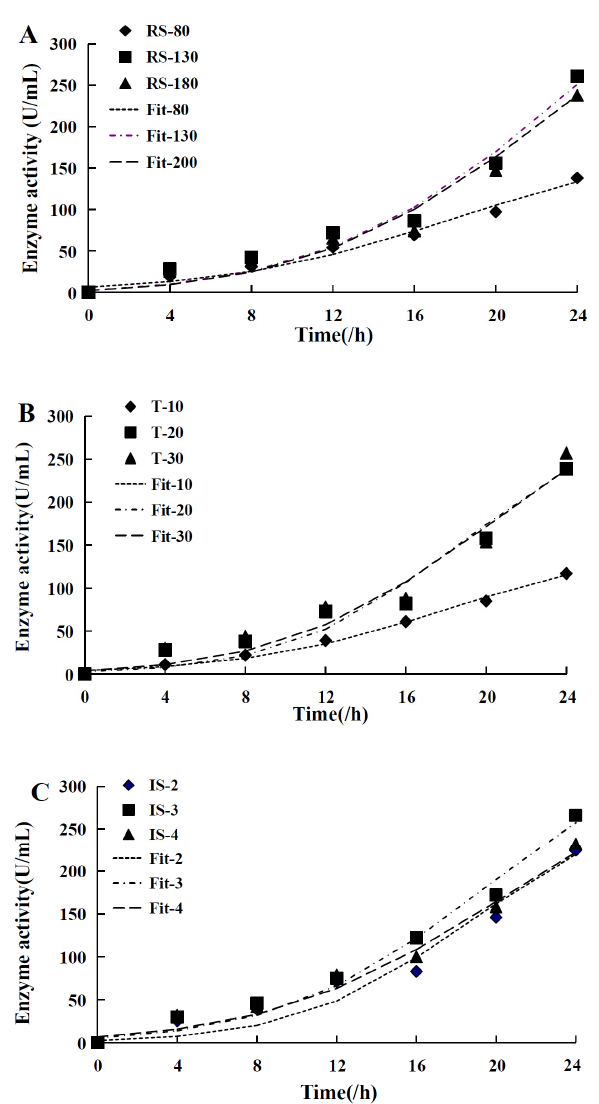
Figure 8. ( A ) was the model fitting of revolving speed relative to enzyme activity, altering variables 80 r/min, 130 r/min and 180 r/min, quantifying temperature 30 °C, and inoculum size 3 mL; ( B ) was the model fitting of temperature relative to enzyme activity, altering variables 10 °C , 20 °C and 30 °C , quantifying revolving speed 130 r/min, and inoculum size 3 mL; ( C ) was the model fitting of inoculum size relative to enzyme activity, altering variables 2 mL, 3 mL and 4 mL, quantifying revolving speed 130 r/min and temperature 30 °C .